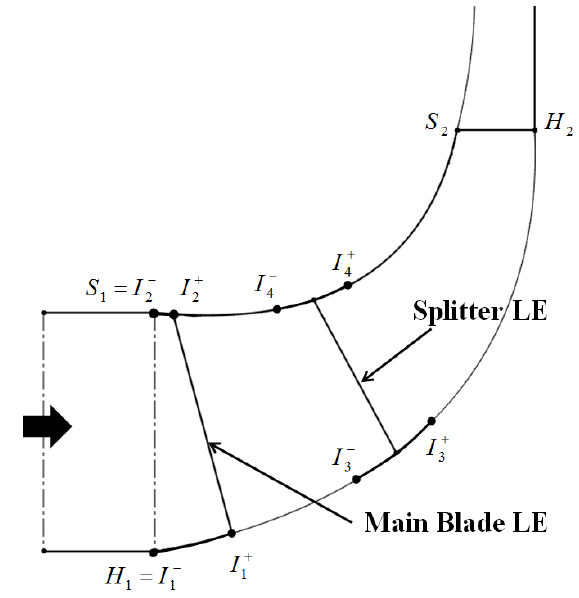
Figure 5. Main blade and splitter leading edge position parameters.